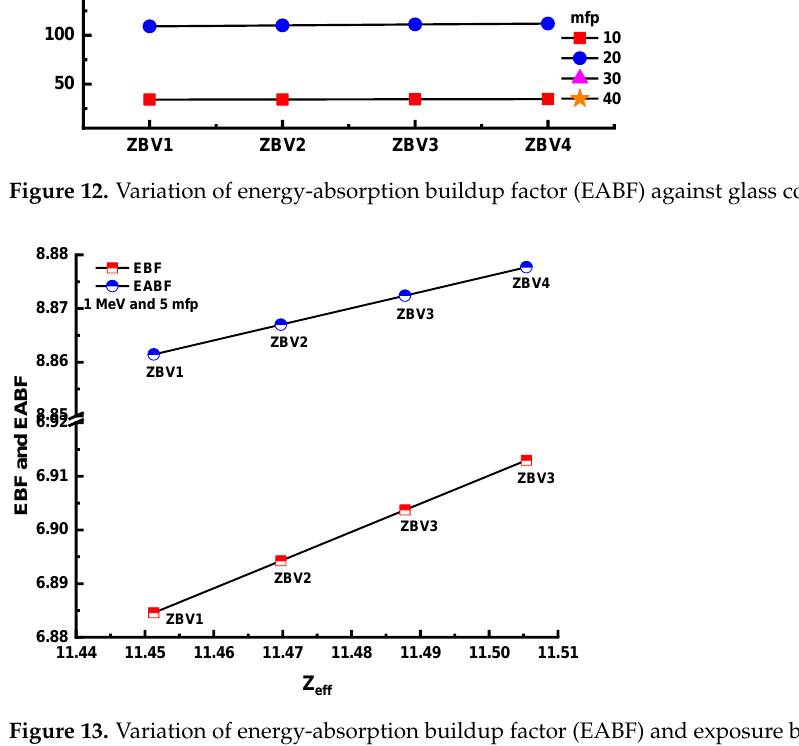
Figure 13. Variation of energy-absorption buildup factor (EABF) and exposure buildup factor (EBF) against effective atomic number (Z eff ) for all glasses.